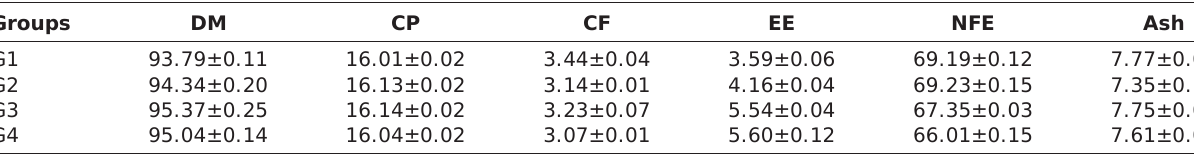
Table-3: Proximate composition (%) of diets used in different groups. Groups